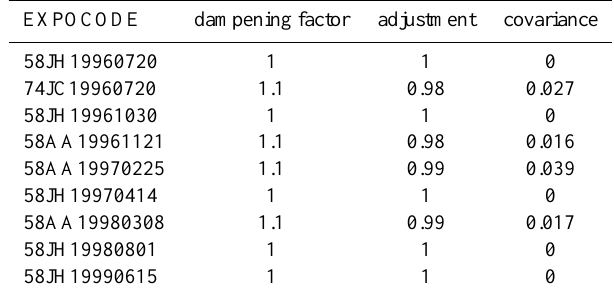
Table 2. Results of the crossover and inversion (WDLSQ) anal- ysis of the cruises falling in a high and a low group, described in Sect.